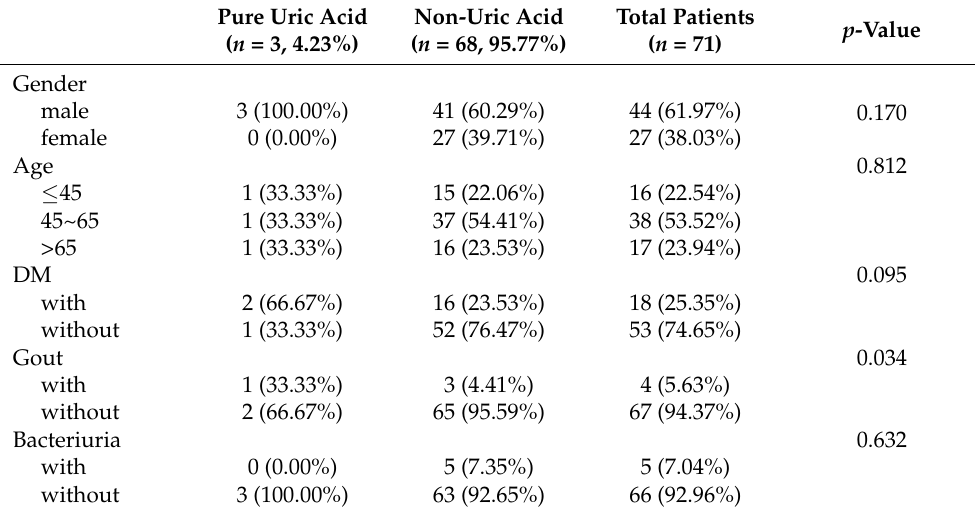
Table 3. Patient characteristics in Cohort B.